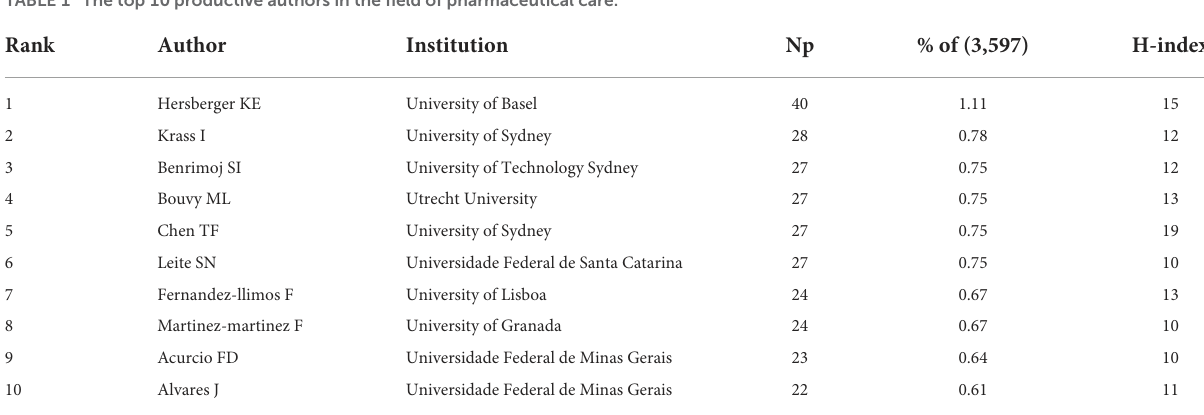
TABLE 1 The top 10 productive authors in the field of pharmaceutical